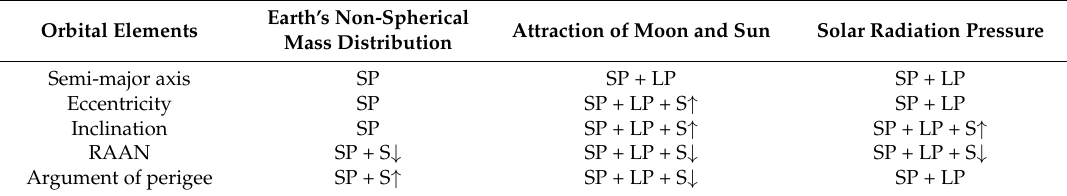
Table 5. Summary of the periodical changing laws of the perturbed GEO SAR orbital elements variations (SP: short periodical term, LP: long periodical term, S: secular